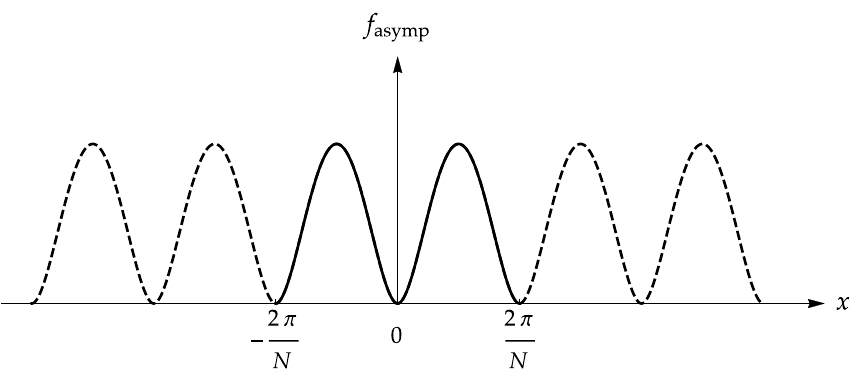
Figure 2 . Continuation of the asymptotic free energy across (cid:13)op